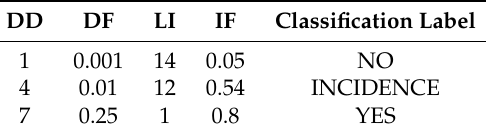
Table 1. Sample training data.